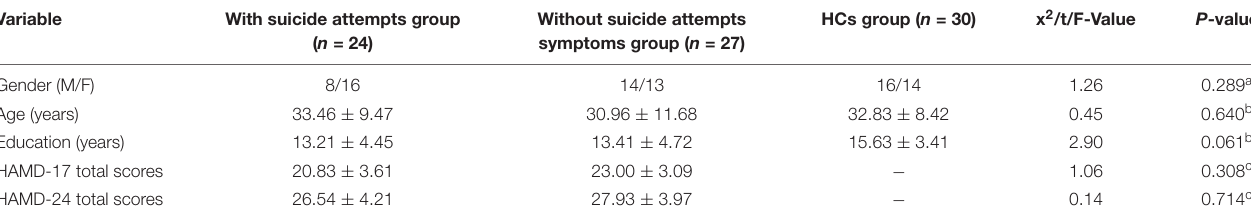
TABLE 1 | Demographic and clinical characteristics of all participants. Variable With suicide attempts group ( n =